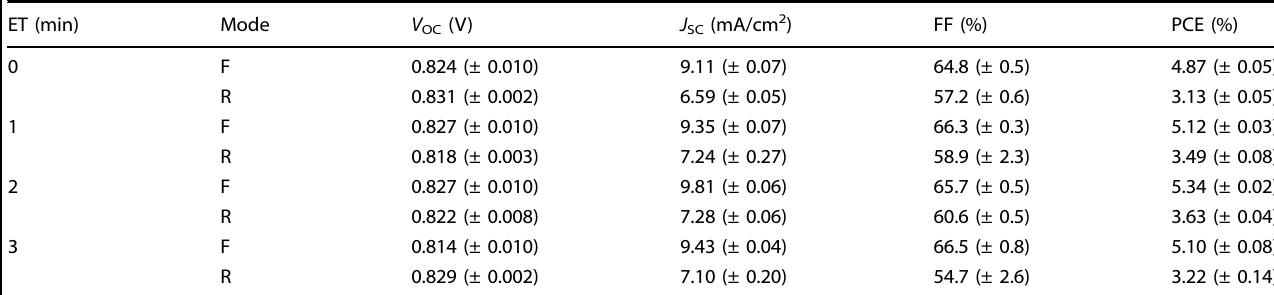
Table 1. Effects of etching time (ET) and irradiance mode (F: front irradiance, R: rear irradiance) on cell performance parameters (averages and standard deviations determined for eight cells). ET